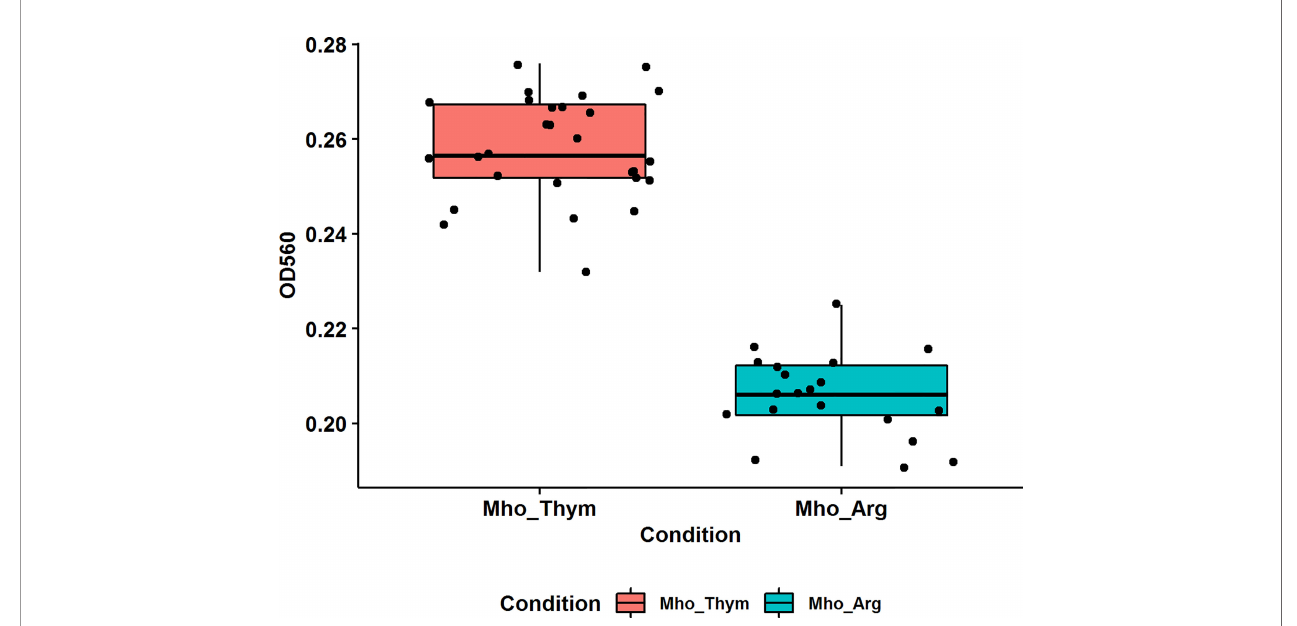
FIGURE 3 | The effect of different carbon sources on M. hominis bio fi lm formation. Bio fi lm production was quanti fi ed by measuring the absorbance (560 nm) of crystal violet in a microplate. Groups are signi fi cantly different, pairwise comparisons using Wilcoxon rank sum test, p-value = 5e-09.